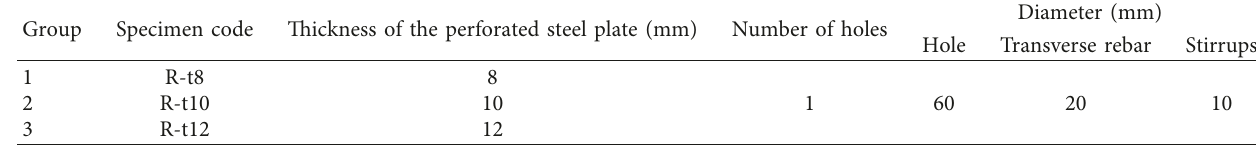
Table 1: Specimen